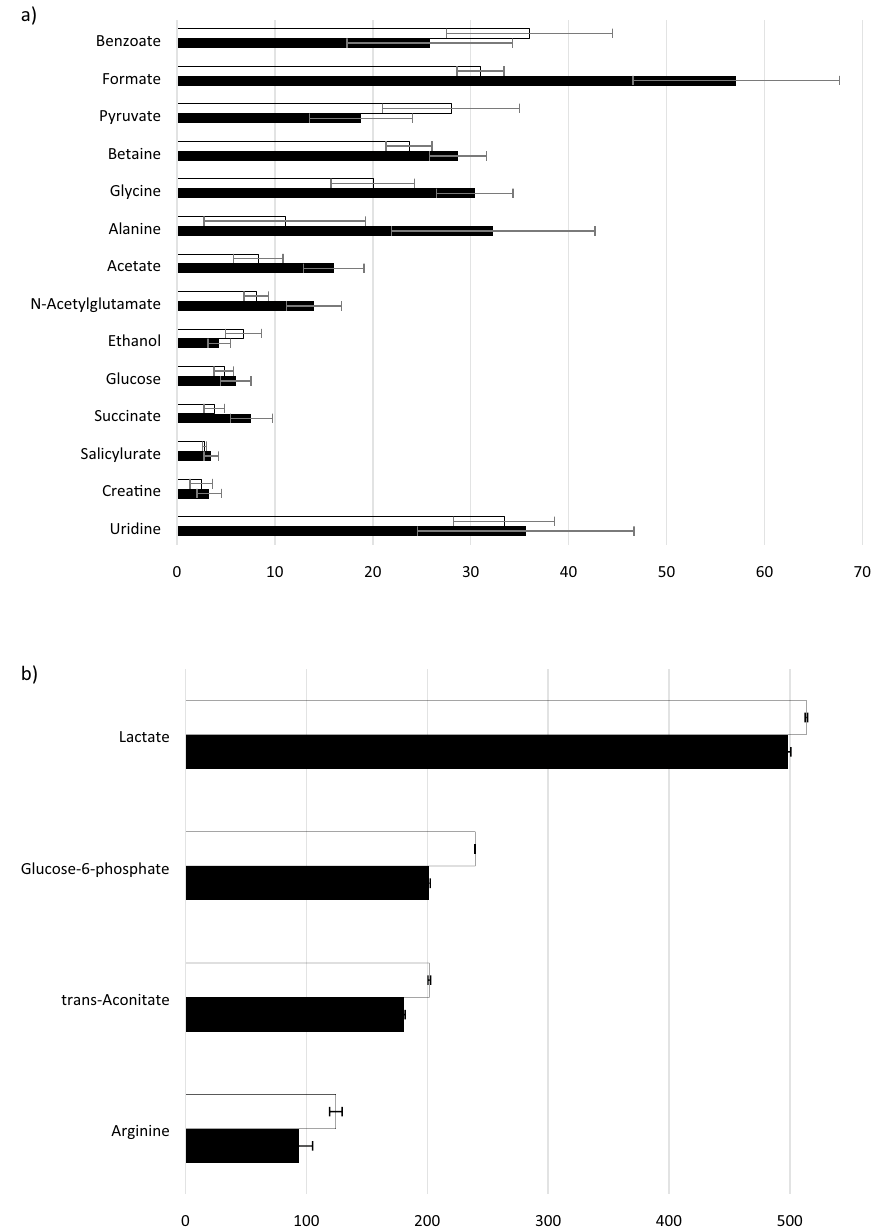
Figure 2. Black square planktonic and black filled square biofilm ( a ) Low concentration range 0–100 mM ( b ) High concentration range 0–500 mM. Summary of the identified metabolites in Mycoplasma fermentans serum contributing an observed variation in component signal intensity of > 10% p = 0.05. Metabolites were assigned using Chemnomx Profiler. Certain duplicate signals (owing to multiplicity of single components in 1D 1 H NMR) have been removed and the signal intensities